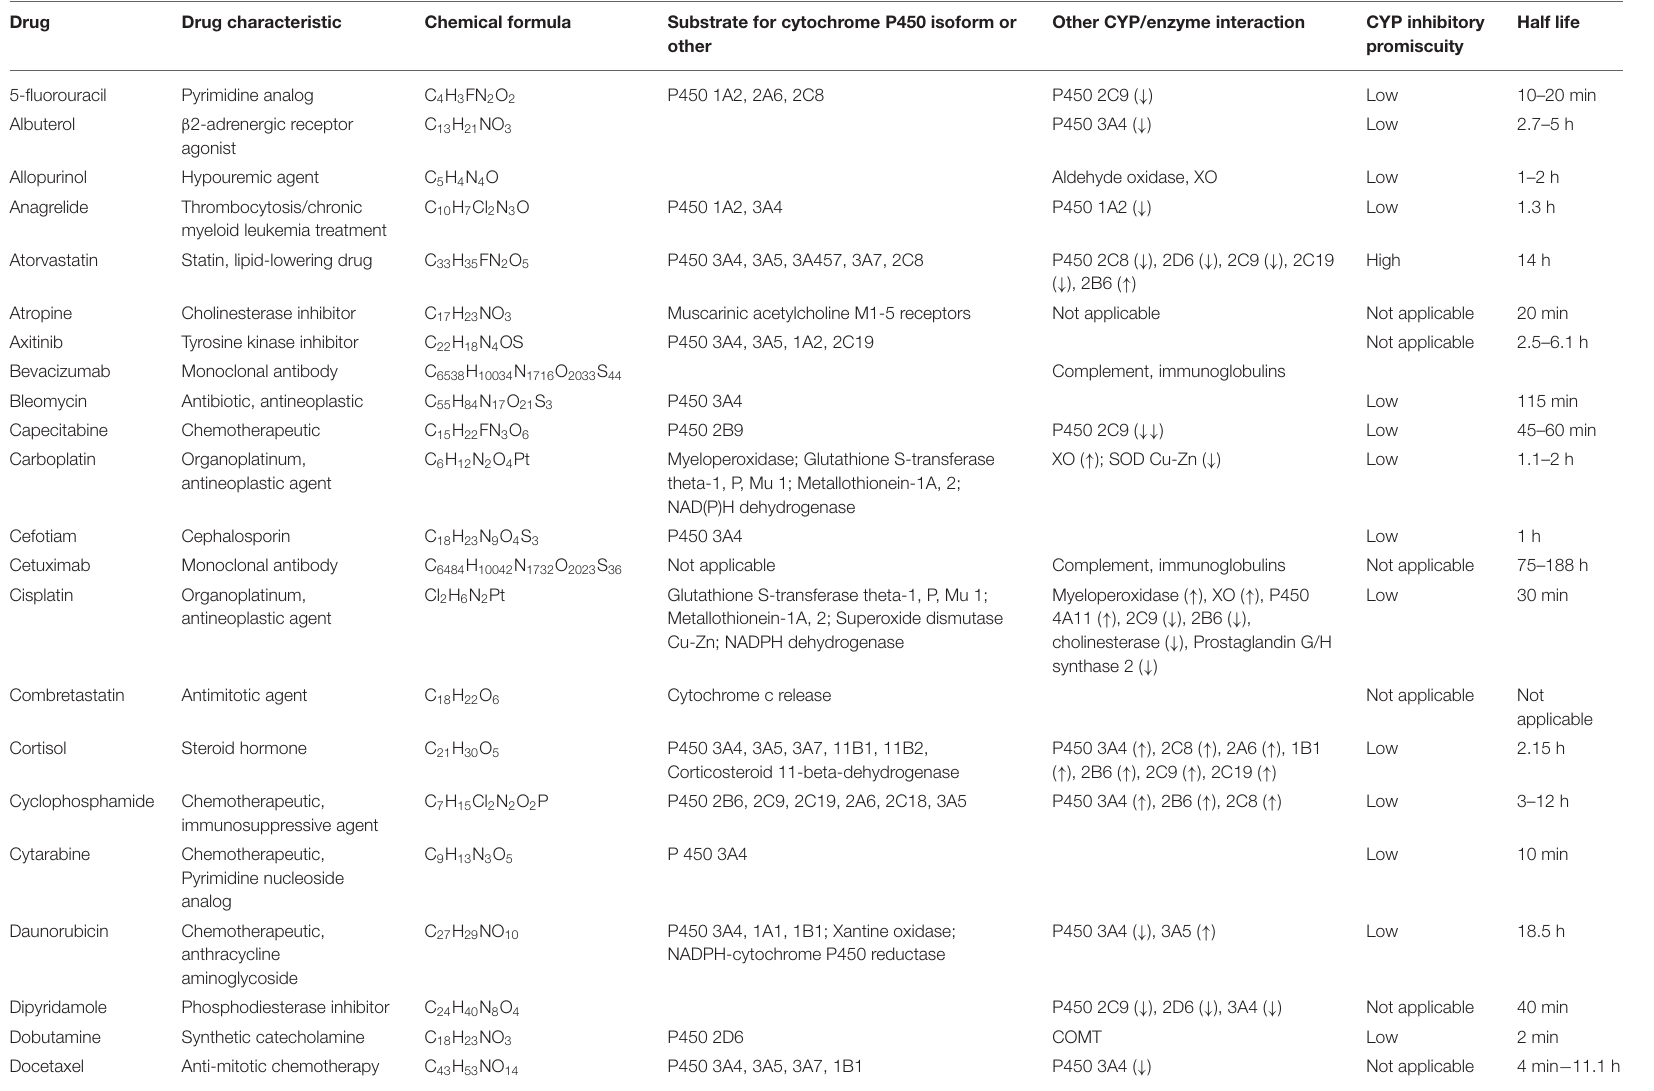
TABLE 2 | Drugs associated with an acute attack of Takotsubo syndrome and their interactions with cytochrome P450 (available from: https://www.drugbank.ca/drugs, https://drug-interactions.medicine.iu.edu/ MainTable.aspx).